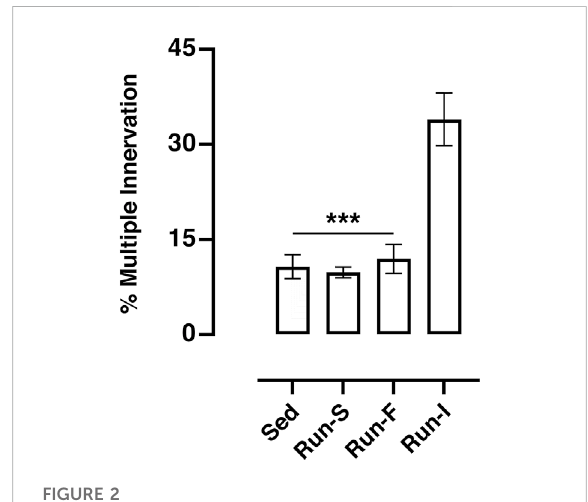
FIGURE 2 Effect of different exercise protocols on soleus muscle multipleinnervation10daysafternervecrush.One-way ANOVA: F (3, 17) = 18.87; Tukey ’ s post hoc test: *** p < 0.001 vs. Run-I.